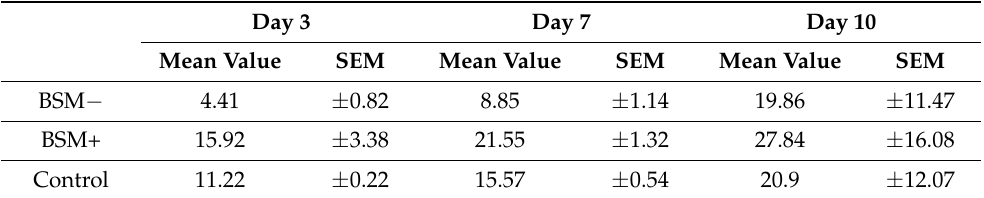
Table 1. Cell Viability. Percentage area fraction (%) of fluorescence-stained HOBs at a ten-fold alone) on days 3, 7 and 10. The mean values are for parametric data and the median values are for non-parametric data.